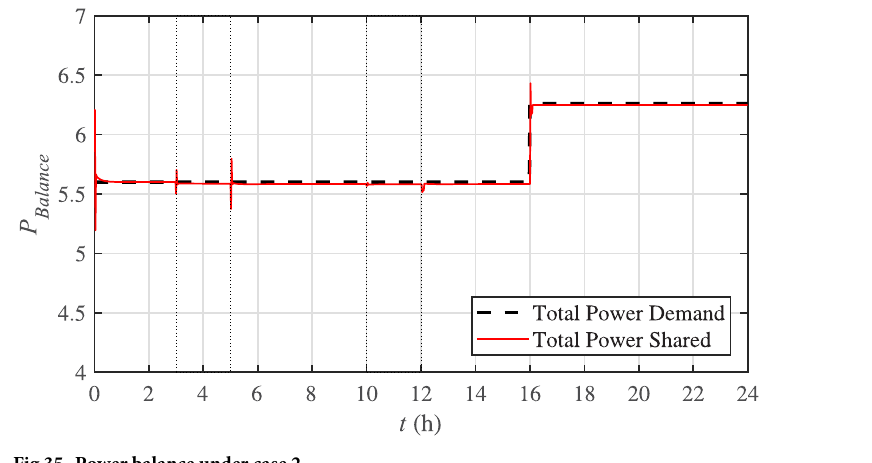
Fig 35. Power balance under case